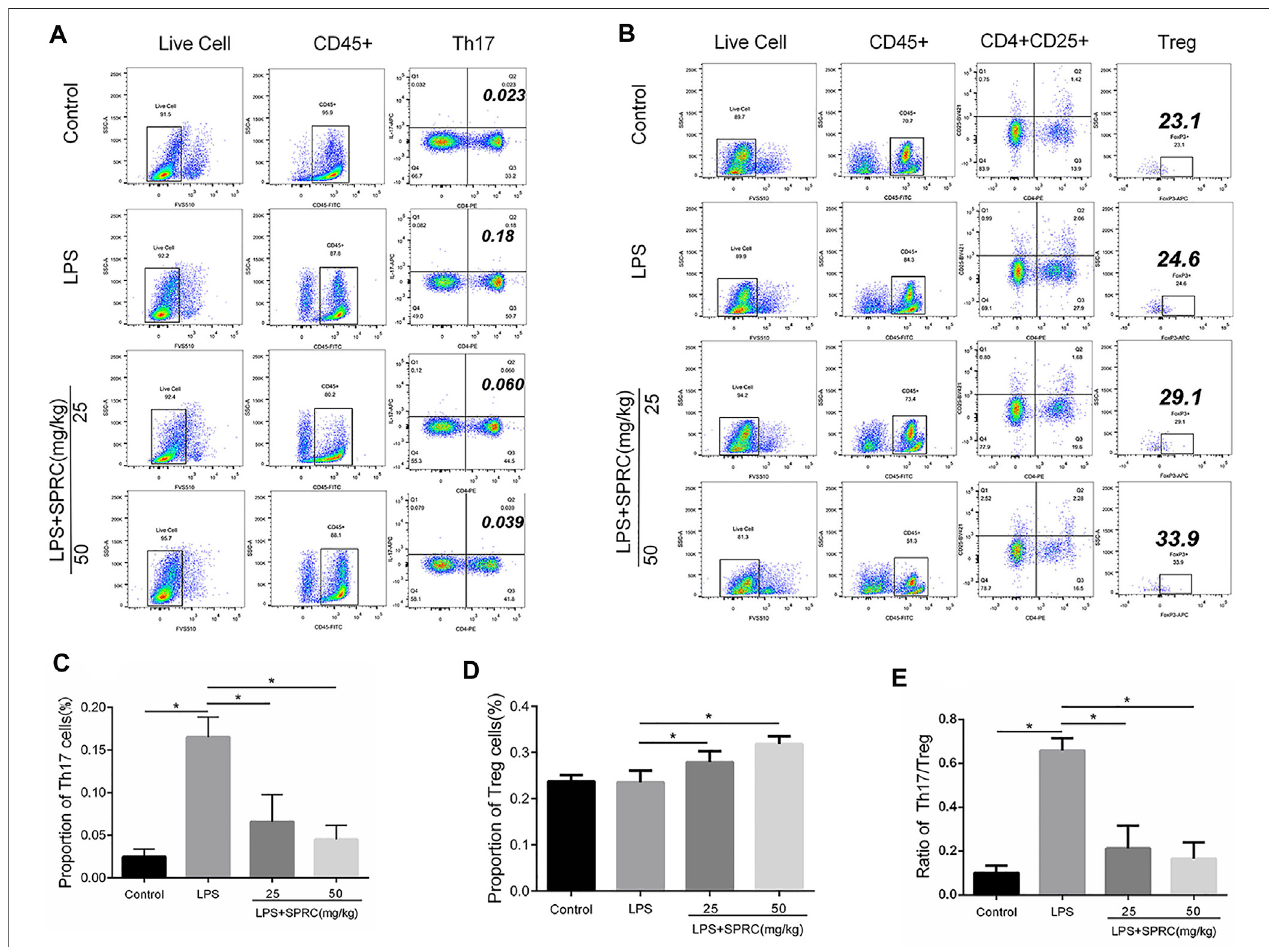
FIGURE 4 | Proportion of Th17 cells and Treg cells. The ratio of Th17/Treg in rats ’ peripheral blood. Live/die (L/D, CD45, CD4, CD25, IL-17A, and Foxp3, was analyzed by fl ow cytometry. (A) Dot plot in the upper separate representation Live Cell, CD45 + , right quadrant represents CD4+IL-17A+(Th17cell) in gated CD45 + cell. (B) DotplotintheupperseparaterepresentationLiveCell,CD45 + ,rightquadrantrepresentsCD4 + CD25+ingatedCD45+cell,Foxp3+(Tregcell)+ingatedCD4 + CD25+ cell (C) : Histogram expression of CD4+IL-17A+(Th17cell) percentages in gated CD45 + cell, (D) Histogram expression of Foxp3+(Treg cell) percentages in gated CD4 + CD25 + cell, (E) Histogram expression of Th17/Treg ratio. Data are shown as the means ± SD from 4 animals. *p < 0.05 vs. LPS